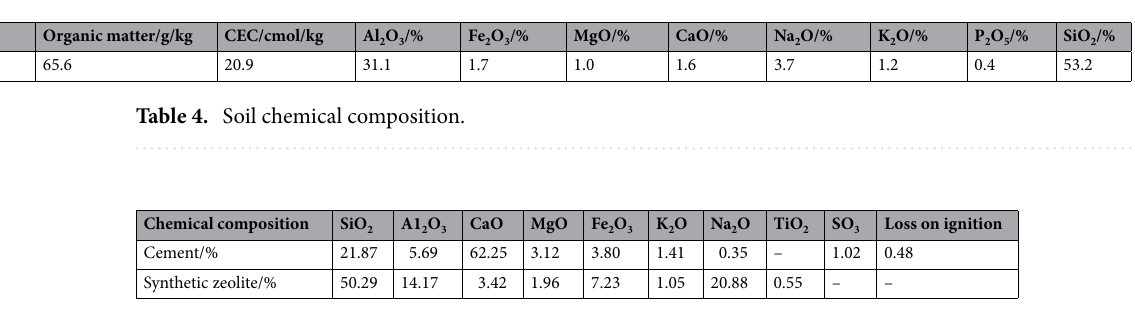
Table 5. Chemical composition of synthetic zeolite and